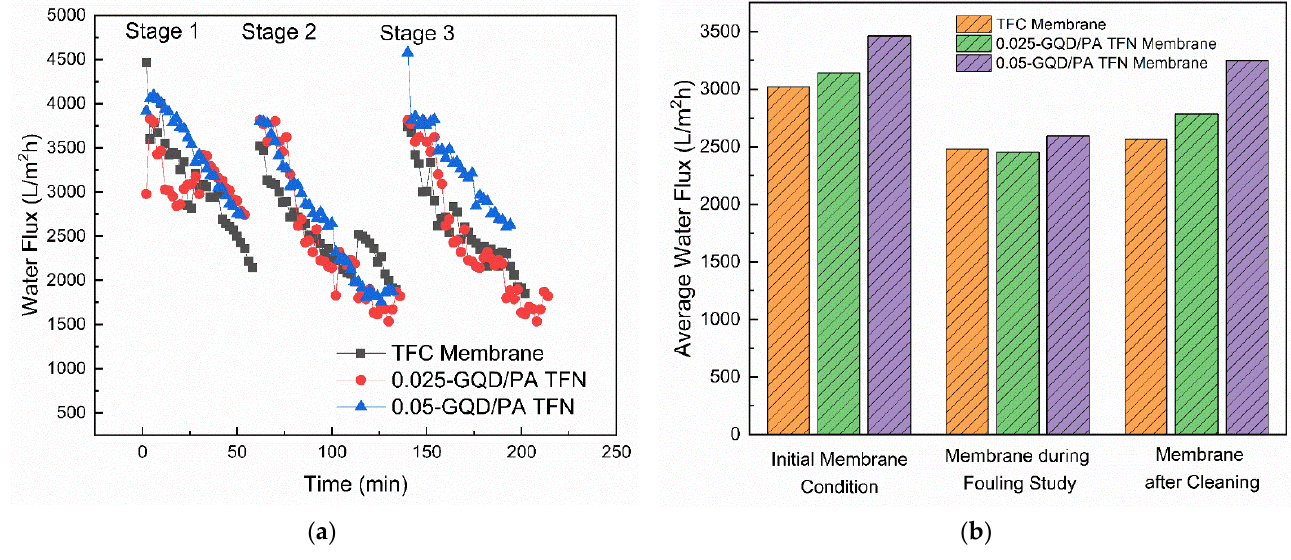
Figure 14. ( a ) Fouling study of the TFC and GQD-based membranes. Stage 1: initial flux (FS: 0.1 M NaCl). Stage 2: fouling study (FS: 0.1 M NaCl+ HA solution). Stage 3: flux after cleaning (FS: 0.1 M NaCl). ( b ) Average water flux of the TFC and GQD-based membranes during the fouling study and cleaning.